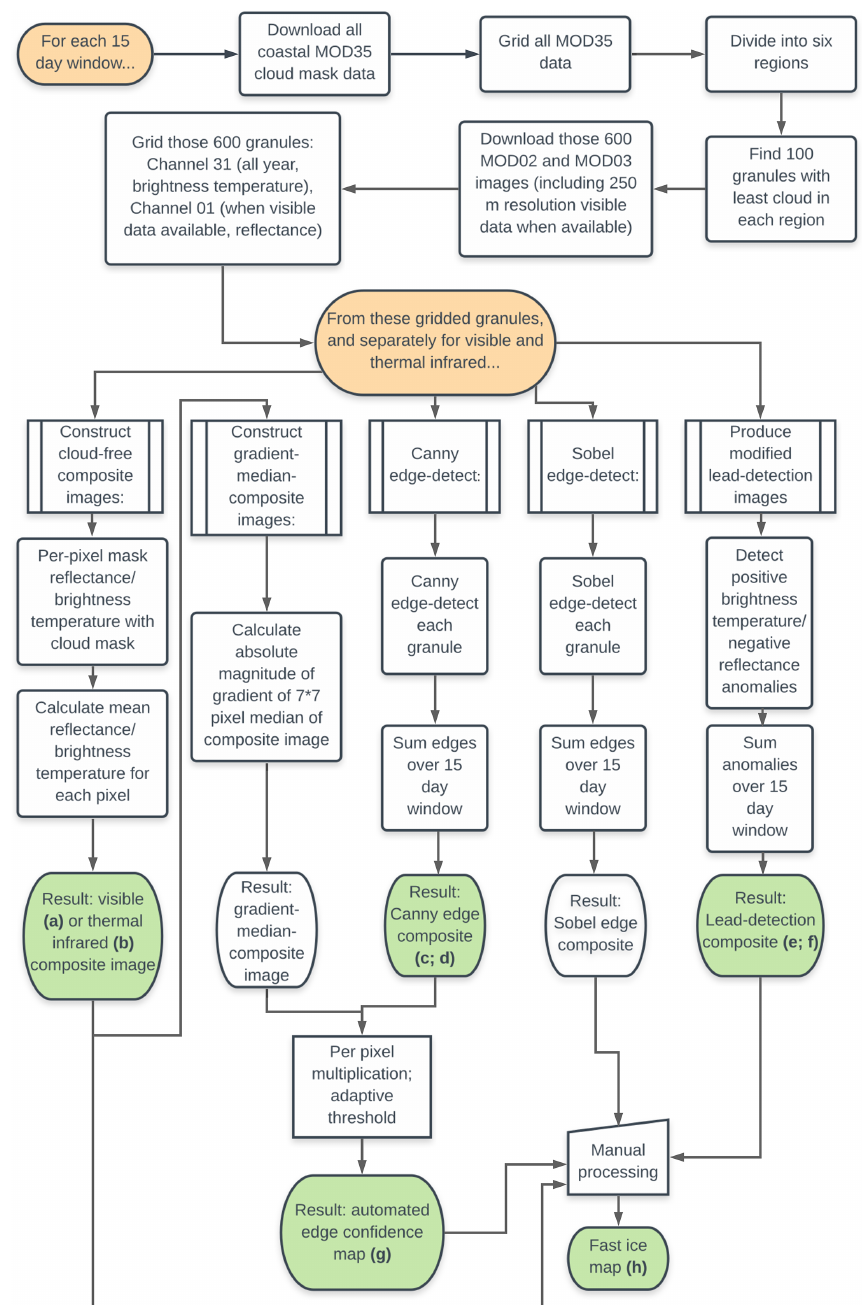
Figure 1. Flow chart depicting the image processing pipeline. Bold letters within the green-coloured elements refer to individual panels in Fig. 2.